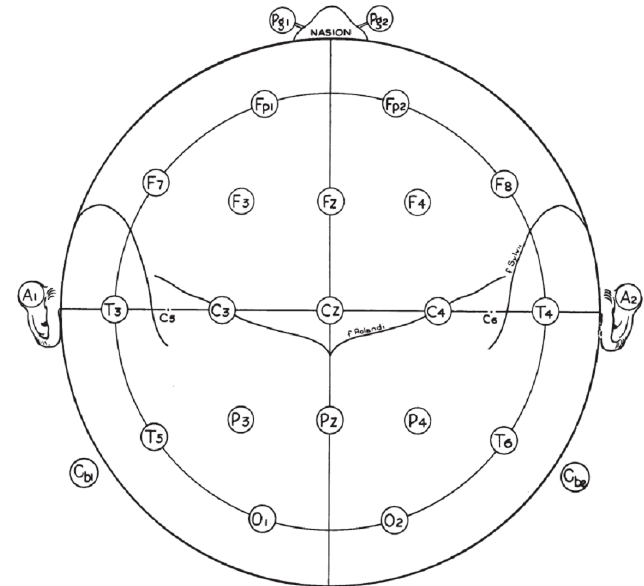
Figure 2. Electrode-positioning standard by International 10/20 System [2]. ‘Pg’ stands for pharyn- geal area, ‘Fp’ for fronto polar, ‘F’ for frontal, ‘T’ for temporal, ‘C’ for central, ‘P’ for parietal, ‘O’ for occipital and ‘Cb’ for